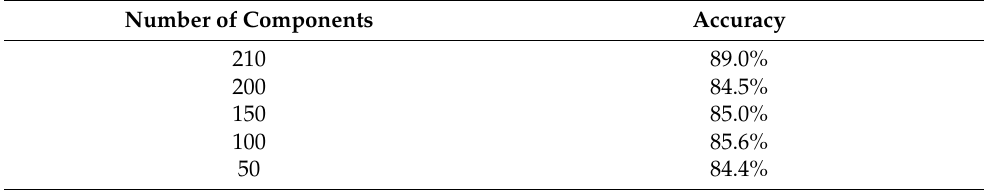
Table 3. PCA dimensionality